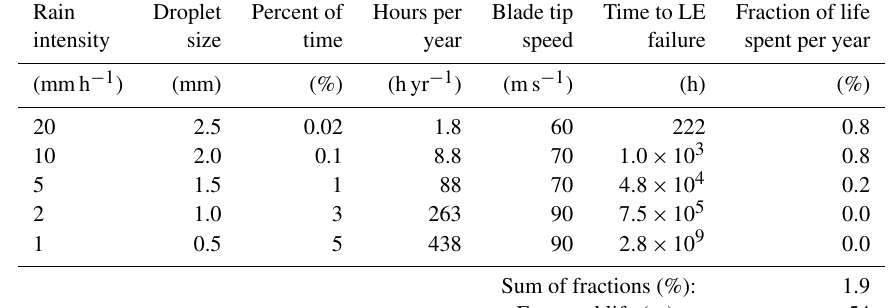
Table 7. Calculation of the expected lifetime of the blade leading edge with a reduction in the tip speed to 60, 70 and 70ms − 1 : Control Strategy 4.